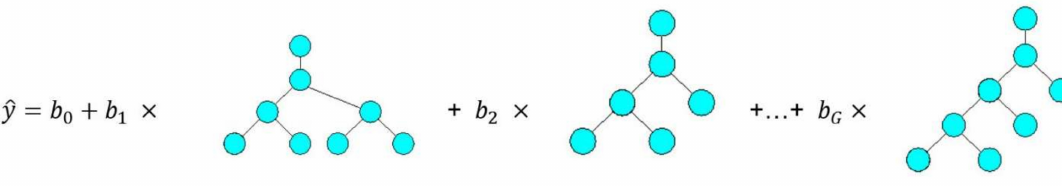
Figure 1. An example of an MGGP model that has two genes.